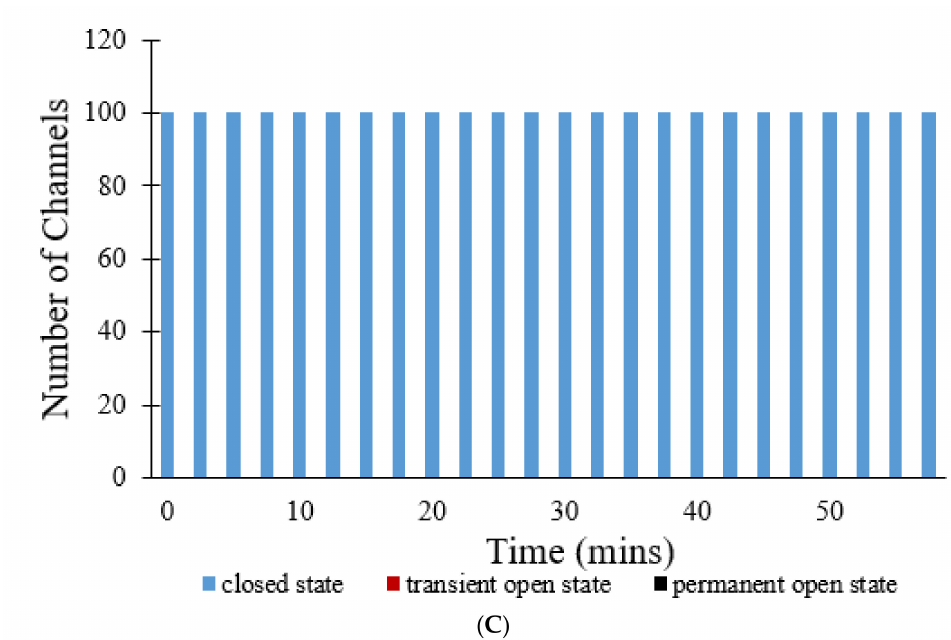
Figure 11. Transition between closed state, open state, and permanent open state for CsA, NAC, and control groups for simulations involving 100 mPTPs. ( A ) Number of pores in each of three different states (closed, transient open, and permanent open) over time. ( B ) Number of pores in each of three different states (closed, transient open, and permanent open) over time with the addition of CsA. ( C ) Number of pores in each of three different states (closed, transient open, and permanent open) over time with the addition of